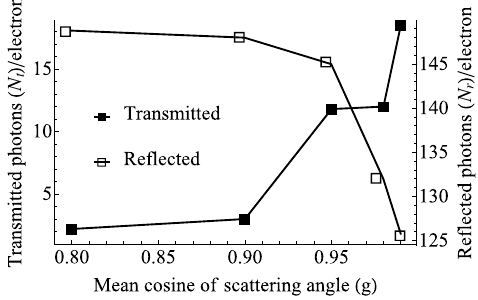
Fig. 3. Dependence of the number of transmitted and re°ected photons on the mean cosine of scattering angle ( E 0 e ¼ 1 : 6 MeV , (cid:2) ¼ 10 : 0 mm (cid:1) 1 , a ¼ 0 : 99, D ¼ 5 : 0 mm ).